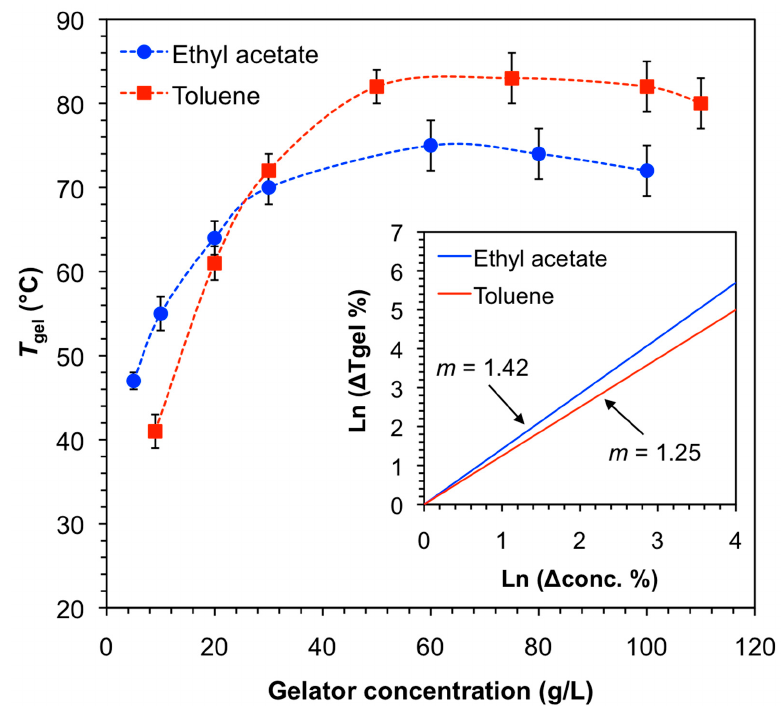
Figure 3. Variation of T gel with increasing gelator concentration for the gels made in toluene and ethyl acetate. Inset: Normalized Ln-Ln plot of T gel percentage increases.